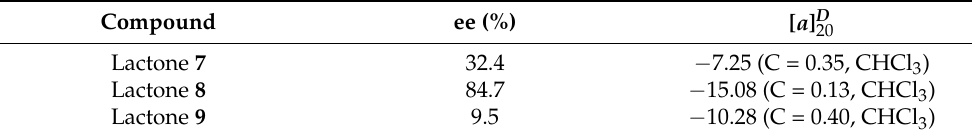
Table 3. The values of enantiomeric excesses and optical rotation of halo-hydroxylactones 7–9. Compound